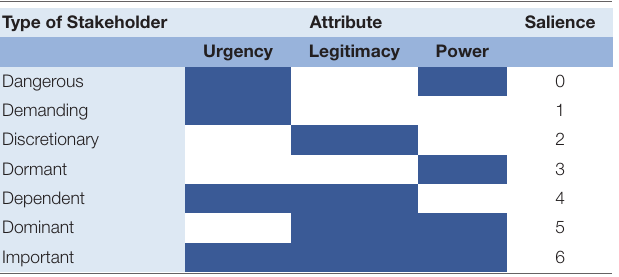
TABLE 2 | Stakeholder attributes and corresponding salience. Type of